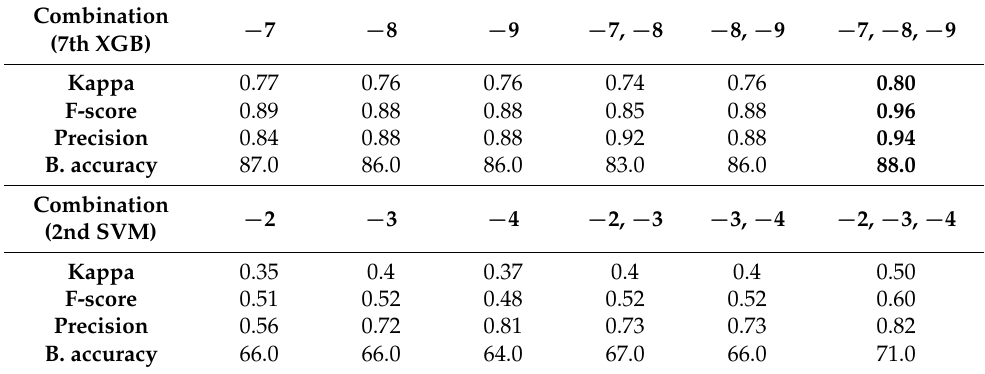
Table 1. Comparison between the performance of single and 2 and 3 consecutive day